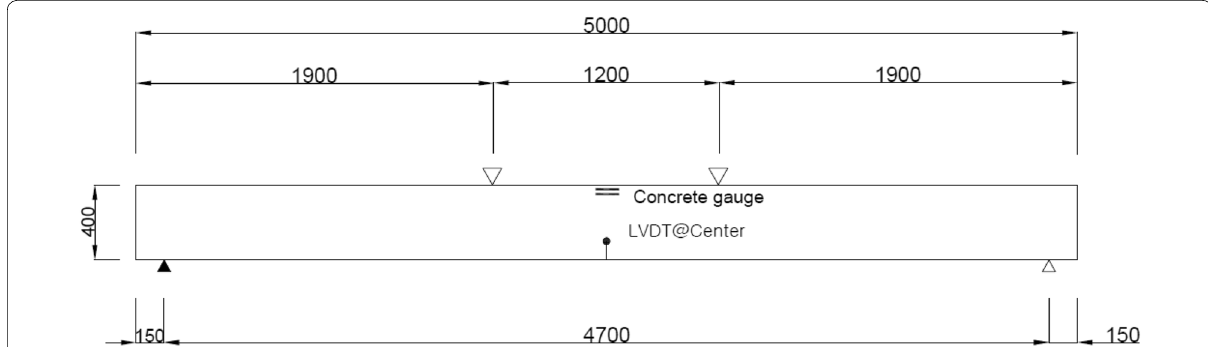
Fig. 5 Set-up and detail of gauges and LVDT (unit: